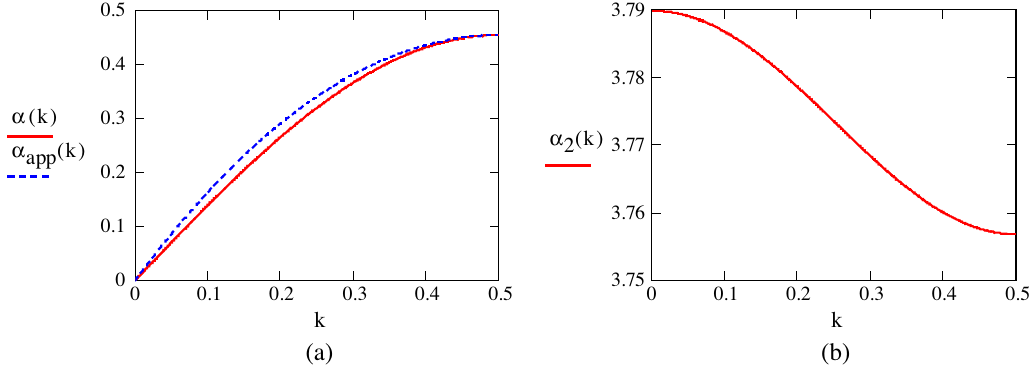
FIG. 5. Dispersion curves corresponding to solution of Eq. (C2). (a) In red is the first passband and in blue its polynomial approximation. (b) The second passband is relatively far away from the first one, and it is one order of magnitude narrower. The eigenvalues are independent of the angle χ 0